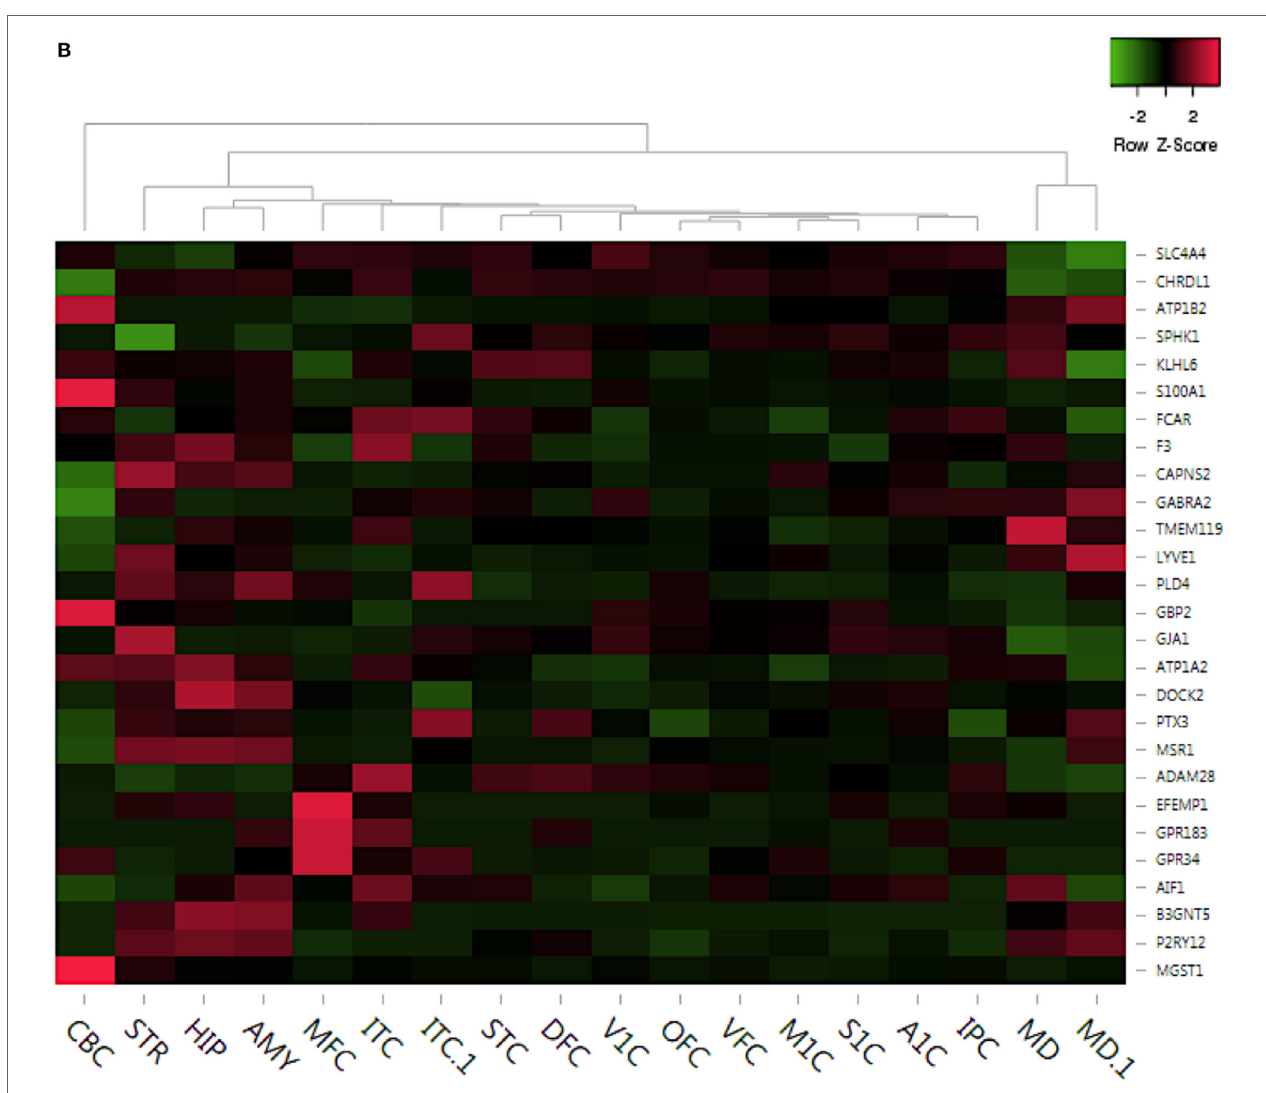
FigUre 5 | Delineation of top dysregulated gene expression profiles across crucial brain anatomic regions associated to neurodevelopment. (a) Prenatal region-wise expression of the top upregulated and downregulated genes. (B) Postnatal region-wise expression of the top upregulated and downregulated genes. Abbreviations: DFC, dorsolateral prefrontal cortex; VFC, ventrolateral prefrontal cortex; MFC, anterior (rostral) cingulate (medial frontal cortex); OFC, orbital frontal cortex; M1C, primary motor cortex (M1); S1C, primary somatosensory cortex (S1); IPC, posteroinferior (ventral) parietal cortex; A1C, primary auditory cortex (core); STC, posterior (caudal) superior temporal cortex (Tac); ITC, inferolateral temporal cortex (Tev); V1C, primary visual cortex (striate cortex, V1); HIP, hippocampus (hippocampal formation); AMY, amygdaloid complex; STR, striatum; MD, mediodorsal nucleus of thalamus; CBC, cerebellar